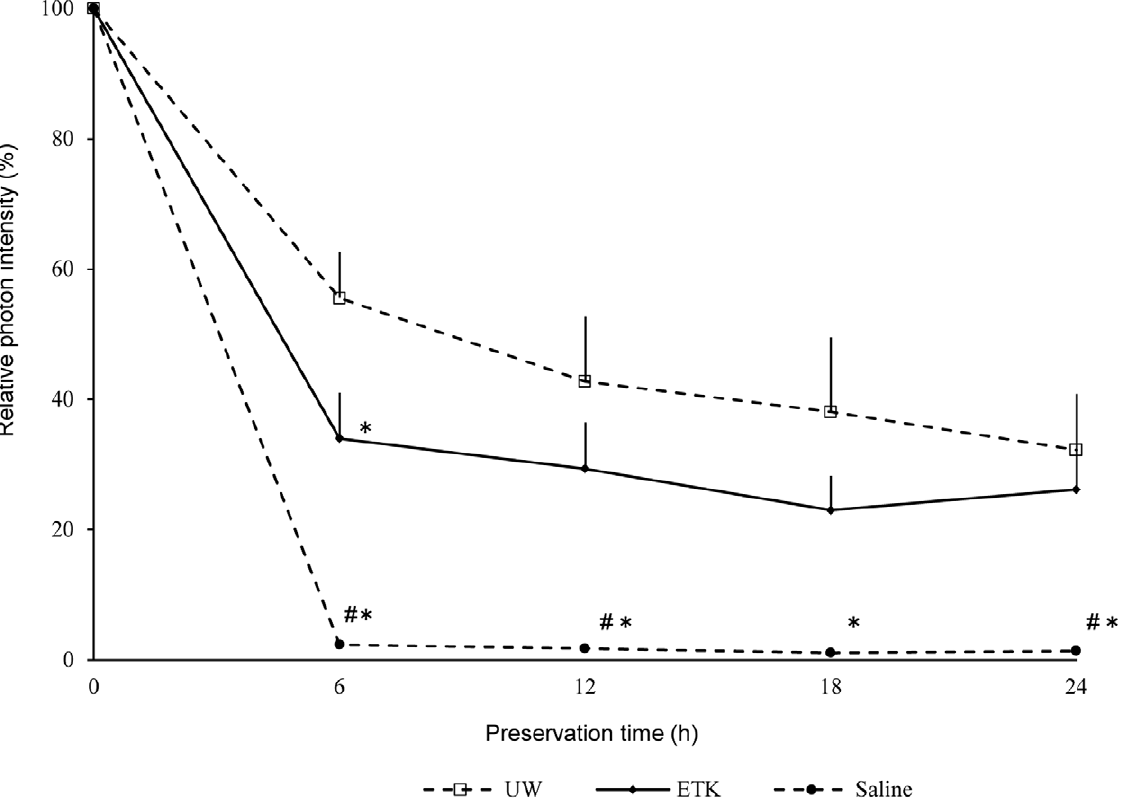
Figure 7. Determination of fluorescence intensity of kidney chips. The fluorescence intensity of the UW group at 6 h after preservation was significantly higher than that of the ETK group (* p , 0.05). However, the fluorescence intensity of both groups was approximately equal at 24 h. ( # p , 0.05 vs. ETK group).